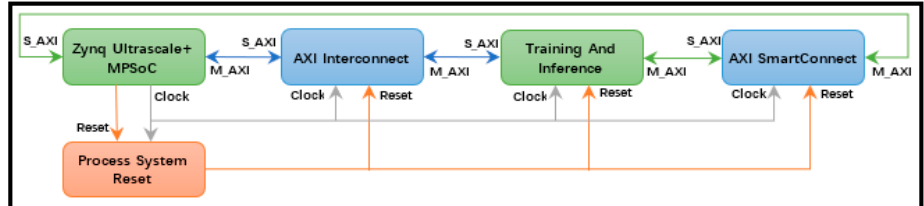
Figure 10. Integrated testing structure of convolutional neural network training and inference built-in MPSoC.